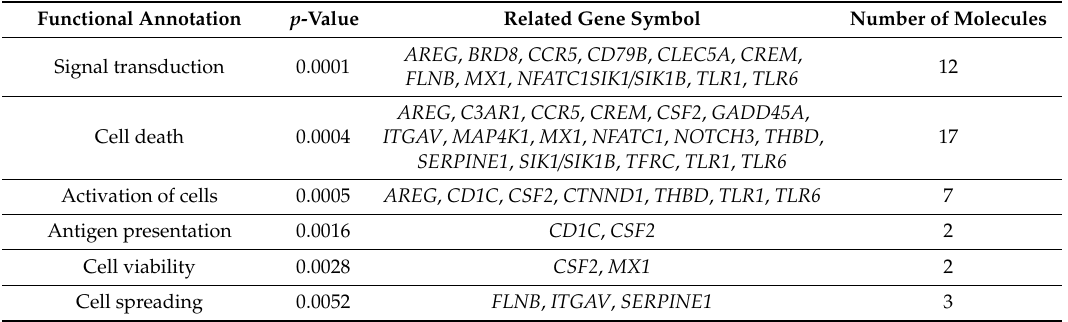
Table 2. Enriched functional annotation of top 100 di ff erentially expressed genes in dendritic cells from patients with